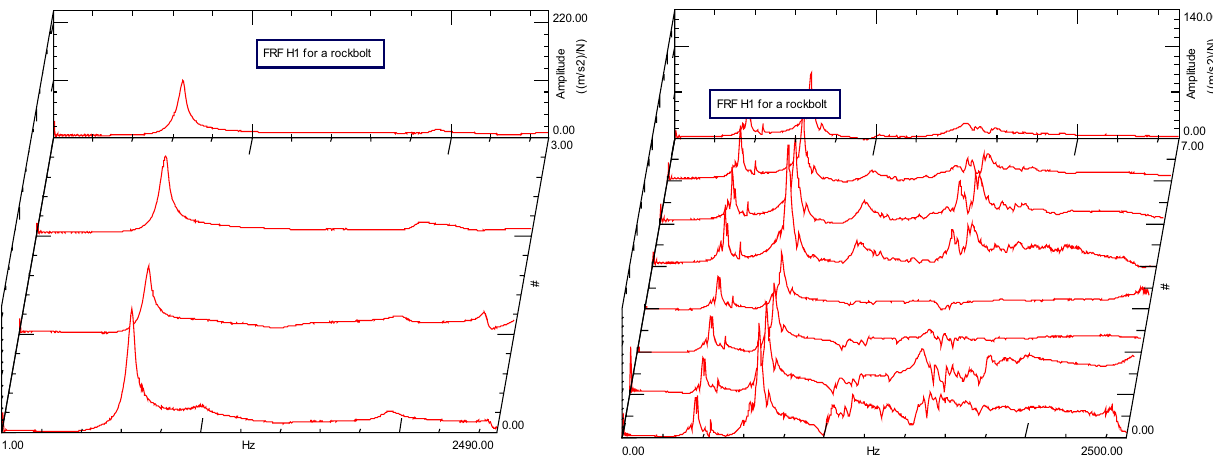
Fig. 3 An examples of the recorded FRF functions for proper (left) and improper (right)